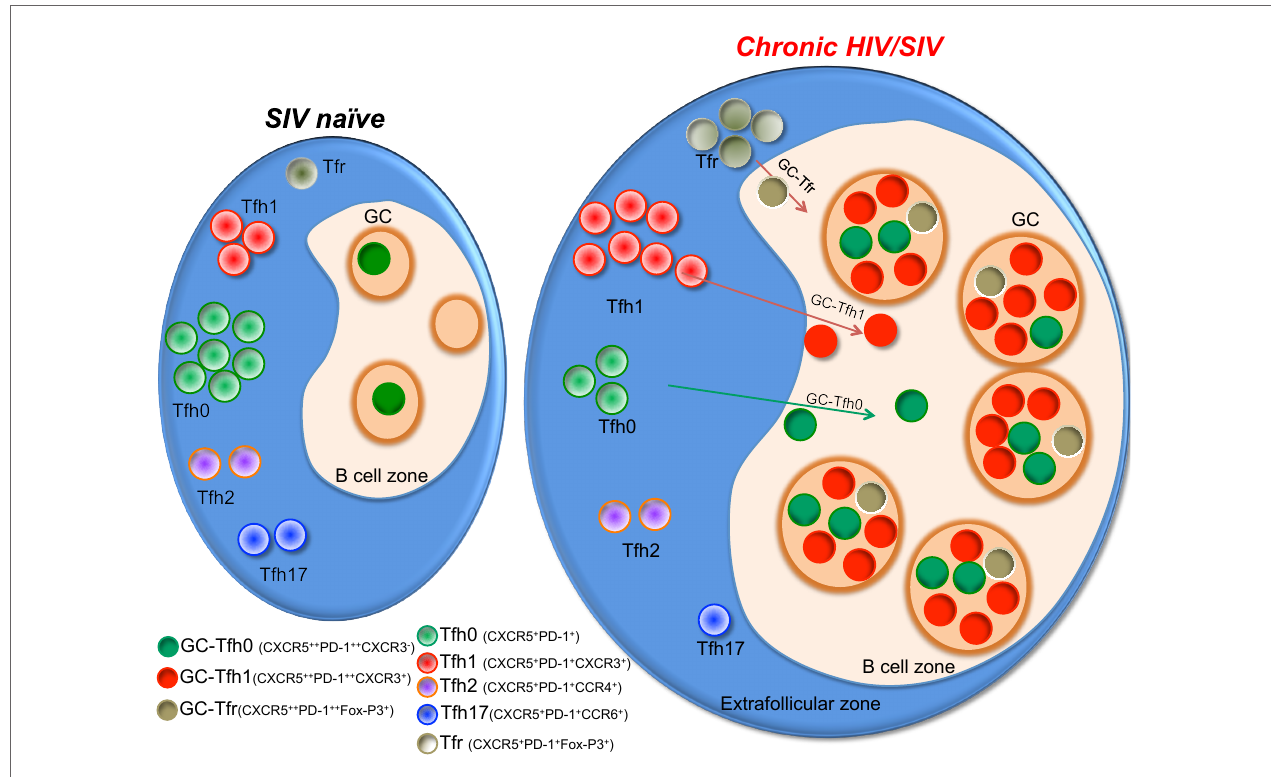
FiGURe 2 | A model showing the status of different germinal center (GC)-Tfh cell subsets during chronic HIV/SIV infection. Tfh cells present as phenotypically distinct subsets with expression of different chemokine receptors pertaining to different lineages of helper CD4 T cells. Upon activation during chronic SIV/HIV infection, there is a massive enrichment of CXCR3 + Tfh cells within the Tfh population in the GC of the lymph node, which in turn drives rapid accumulation of Tfh1 cells. Typical progressors will present with hyperplastic follicles containing a high density of GC-Tfh cells with high levels of CXCR3